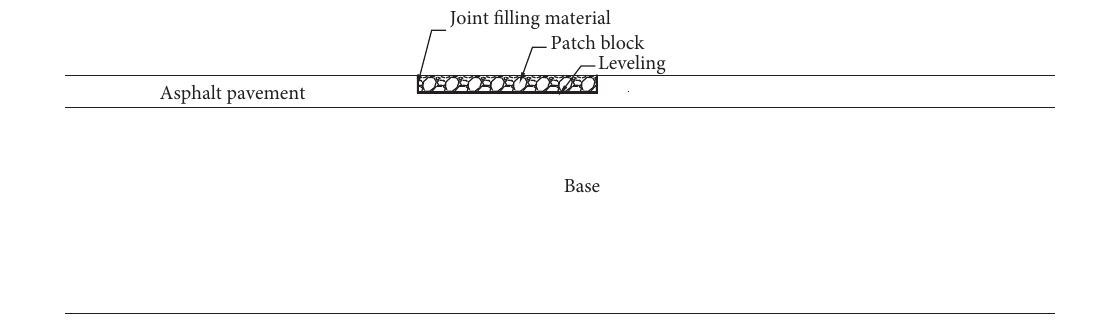
Figure 1: Pothole maintenance Table 1: Pavement structure parameters.